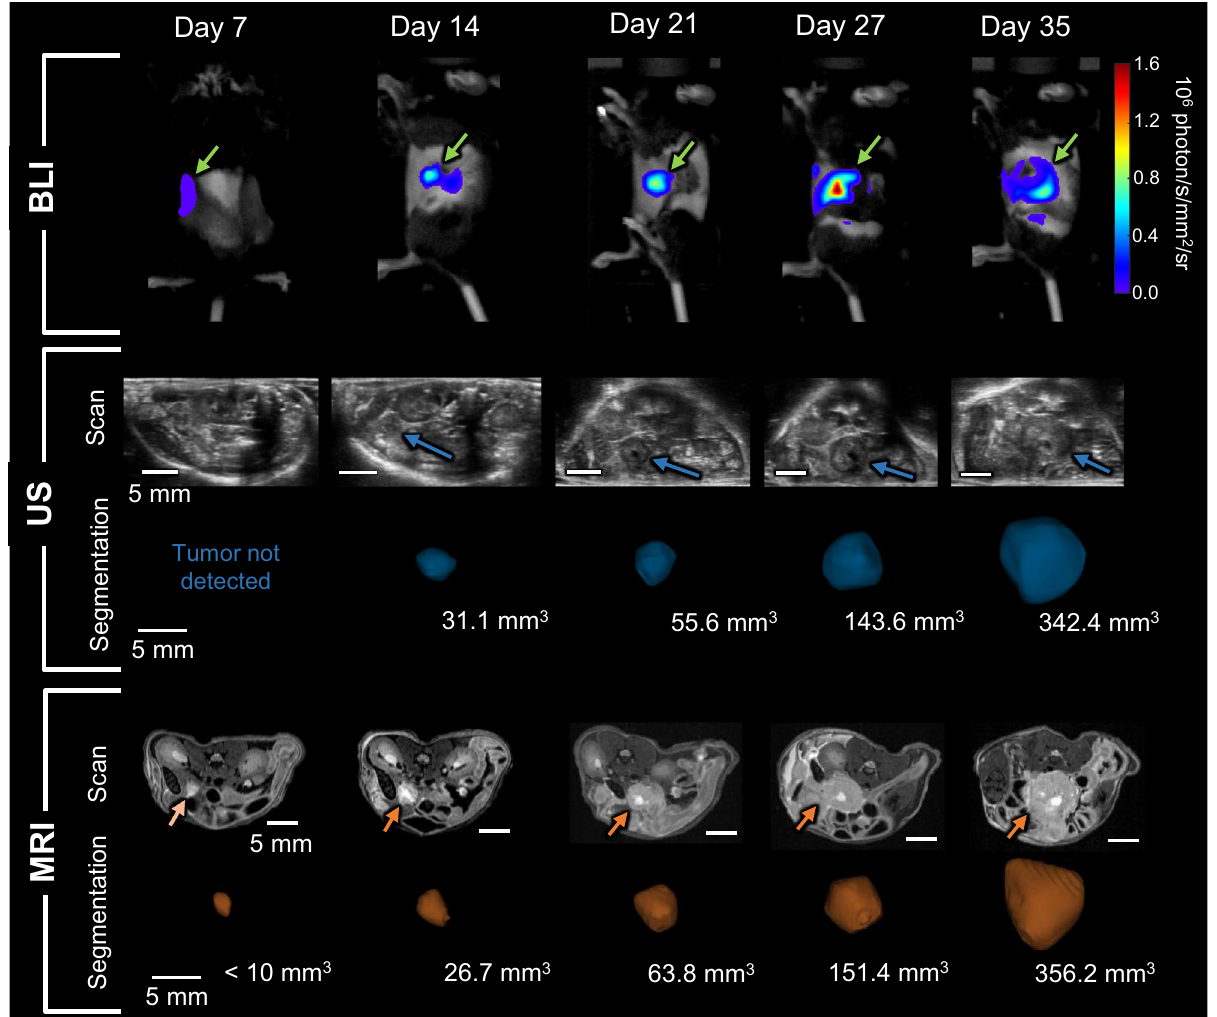
Figure 2. Representative BLI, US, and MRI images through time. BLI, US, and MRI images for 5 imaging timepoints are shown in the first, second, and fourth rows, respectively. Rows 3 and 5 show the 3D rendering of the segmented tumor and its measured volume for each modality. Green (BLI), blue (US), and orange (MRI) arrows point to the tumors. Accurate volume measurement was not possible on the first timepoint. US and MRI images were rotated to show the mouse in the prone position and consist of an axial slice through the